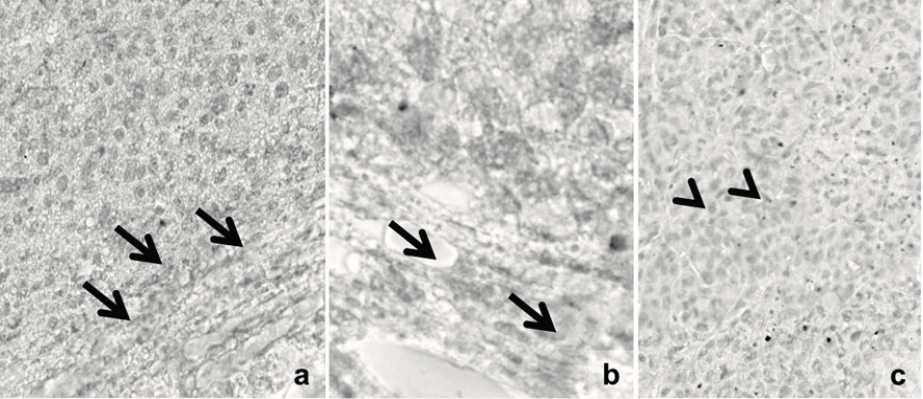
Figure 9. Representative pictures of platelet-derived growth factor receptor β (PDGFR β )-immunostaining. Only a mild intratumoral reaction is seen in the peritumoral stromal myofibroblasts ( a , b ) and in the tumor cells ( c ), independently of the nature of the groups. Arrows and arrowheads highlight peritumoral stromal cells and intratumoral positive tumor cells, respectively. Dacarbazine red reaction; optical scanning microscopy—OM